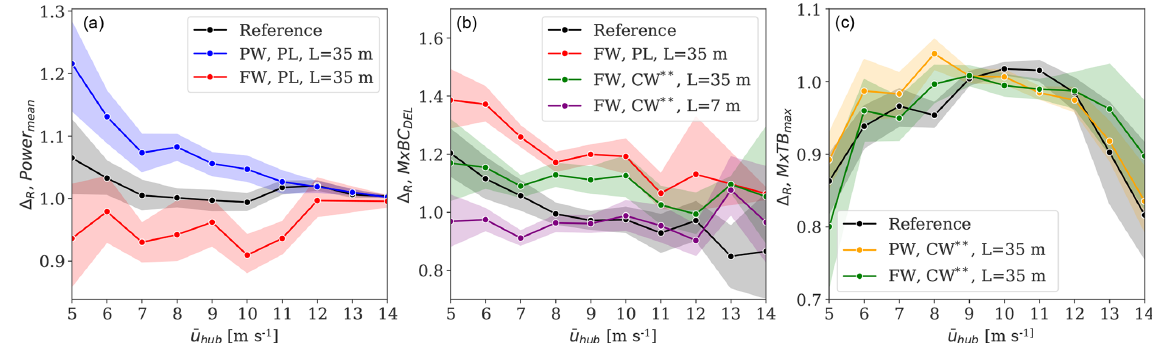
Figure 11. Comparison of bias (solid line) and uncertainty (error band) of (a) mean power production, (b) fatigue flapwise bending moment at the blade root, and (c) extreme fore–aft tower bottom bending moment, with respect to inflow mean wind speed. The analysed cases are shown with coloured lines in each sub-plot. The reference case denotes the mast-based free-wind scenario; PW refers to partial-wake conditions and FW refers to full-wake conditions. We show results from both PL and CW lidars and different turbulence length scales L . The marker ∗∗ indicates unfiltered turbulence obtained from the ensemble-average Doppler spectrum of the radial velocity at 1.3 D